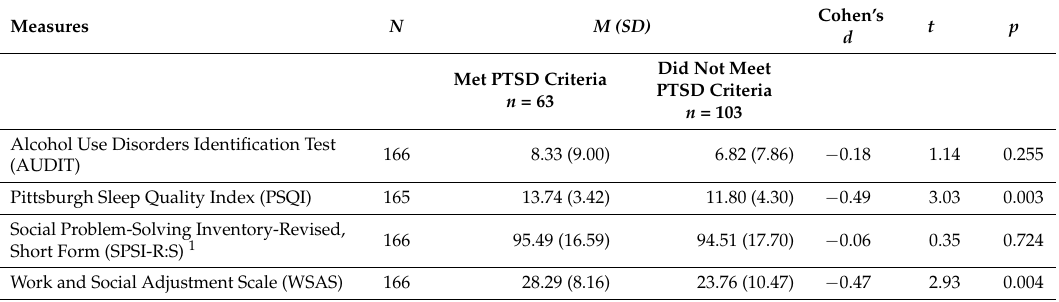
Table 2. Mean difference in functional impairment measures across participants with lifetime suicide attempt histories who did or did not meet PTSD criteria.